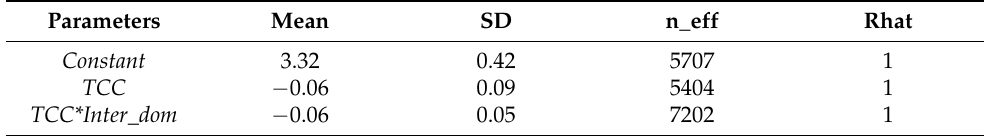
Table 4. Model 3 (cid:48) s simulated